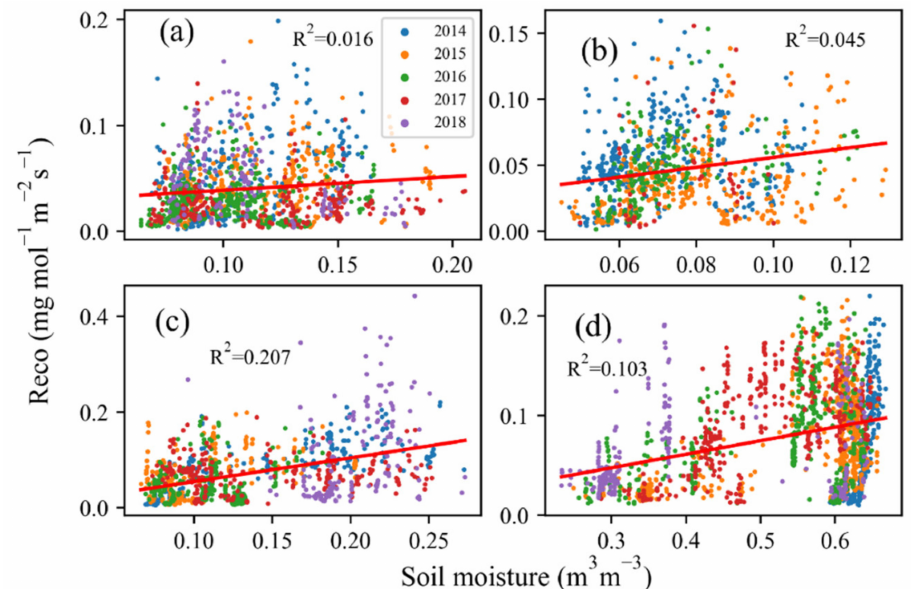
Figure 4. Response of nighttime ecosystem respiration (R eco ) to soil moisture for the four study sites in different years: ( a ) SHB in 2014–2018, ( b ) DRY in 2014–2017, ( c ) TEMP in 2014–2018, and ( d ) MDW in